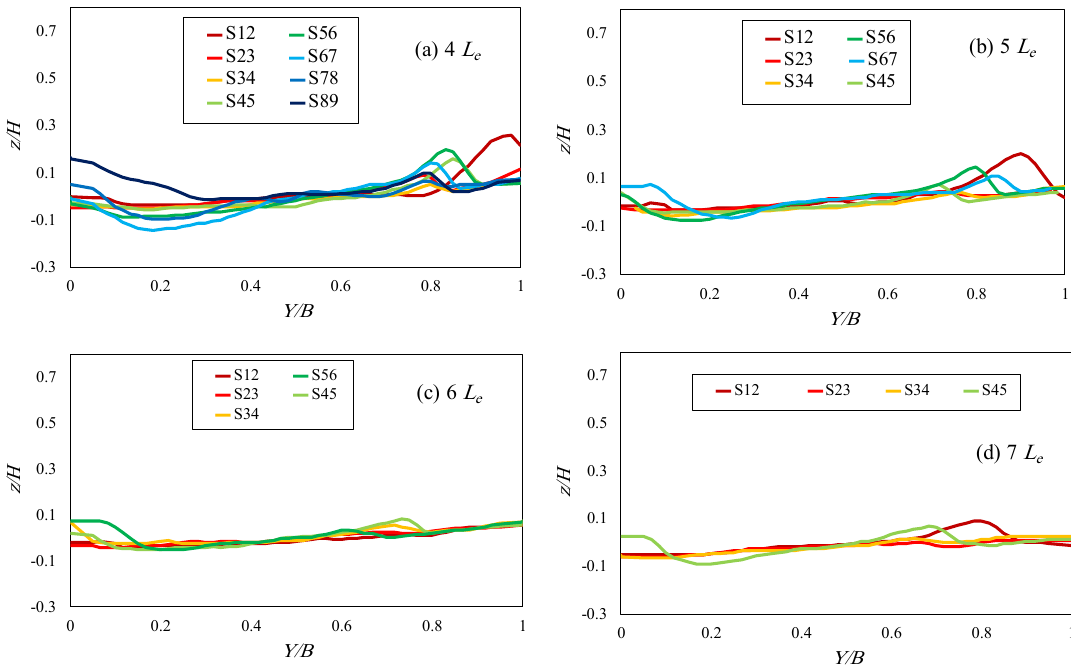
Figure 11. Cross sections between two consecutive structures at particle Froude number of 2.18. ( a ) 4 L e , ( b ) 5 L e , ( c ) 6 L e , and ( d ) 7 L e .